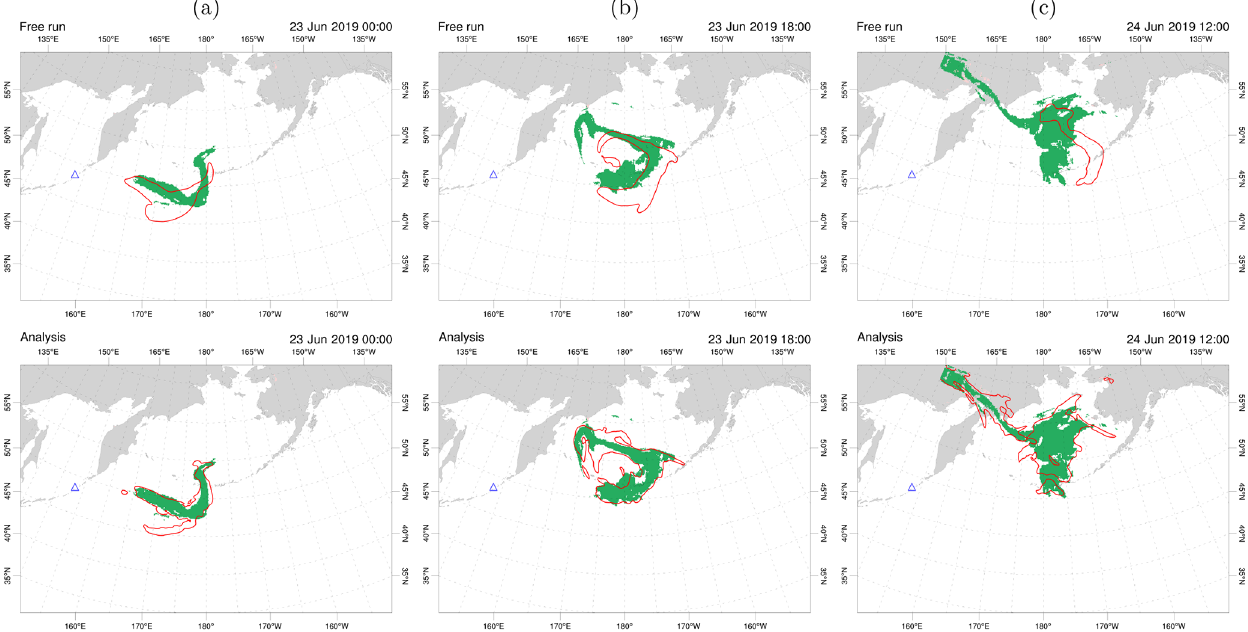
Figure 11. Maps of 1g m − 2 contour of SO 2 mass loading according to observations (green shaded area) and model (solid red line) for different instants of time: (a) 00:00UTC on 23 June 2019, (b) 18:00UTC on 23 June 2019 and (c) 12:00UTC on 24 June 2019. Model results corresponding to the free run (top panel) and the analysis (bottom panel) are compared. A localisation radius of L R = 2 ◦ was defined for the data assimilation